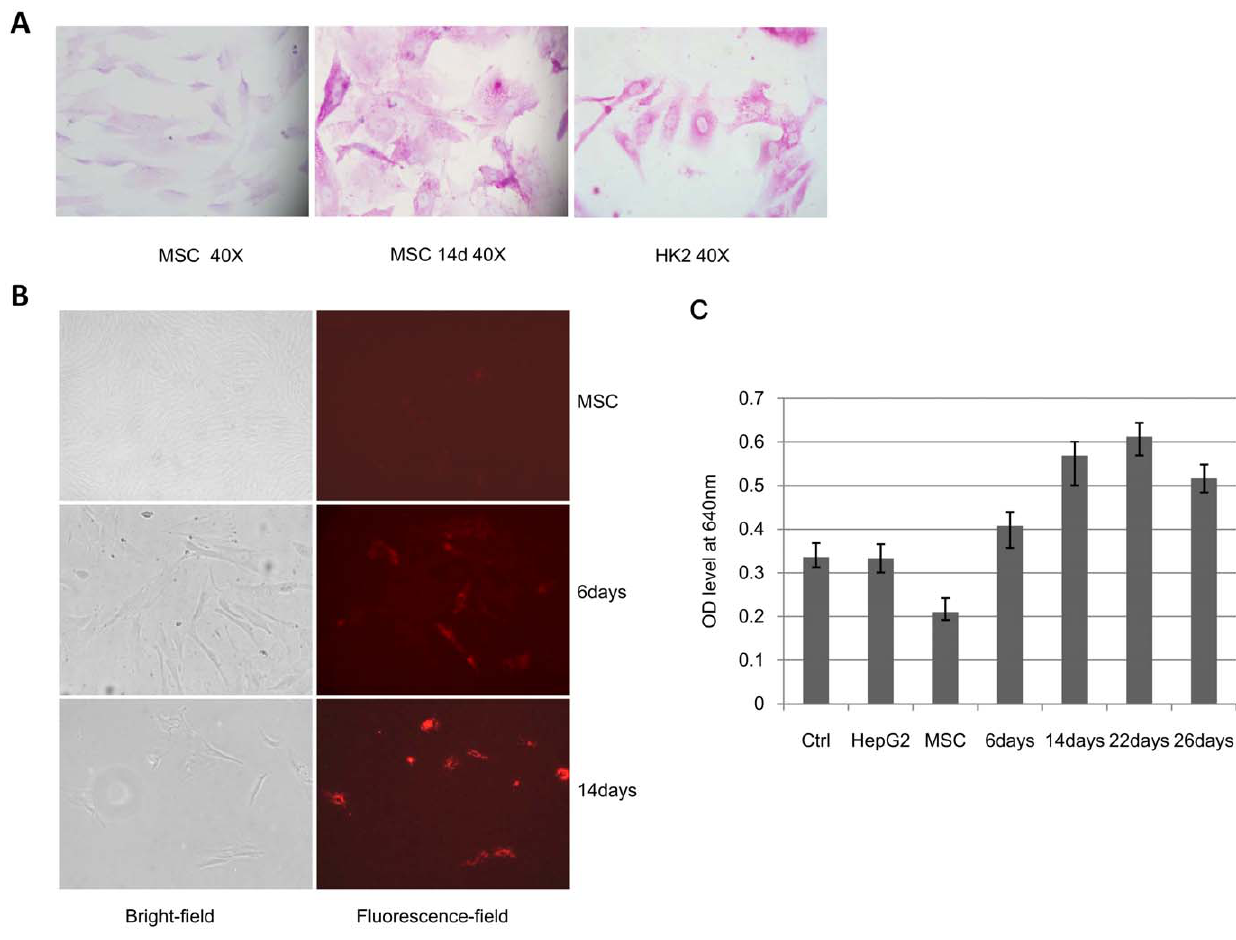
Figure 2. Hepatic differentiated hUC-MSCs possess hepatocyte-specific functions. A: PAS staining of hUC-MSCs before and after hepatic differentiation using HK2 as a positive control. B: Analysis of the LDL uptake ability of hepatic differentiated hUC-MSCs. C: Analysis of the BUN synthetic ability of hepatic differentiated hUC-MSCs.